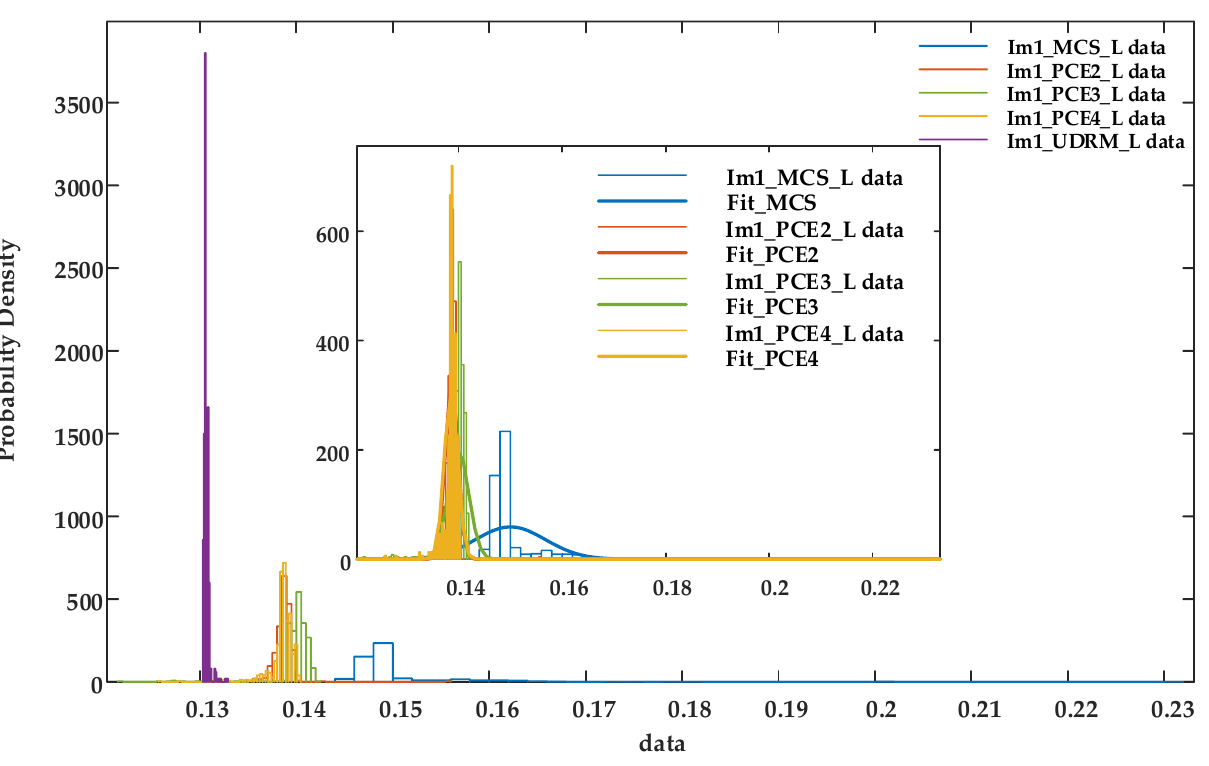
Figure 9. The probability density of the calculated data of I m1 using the 5 different methods under 50% uncertainty of the cable length under normal operation.